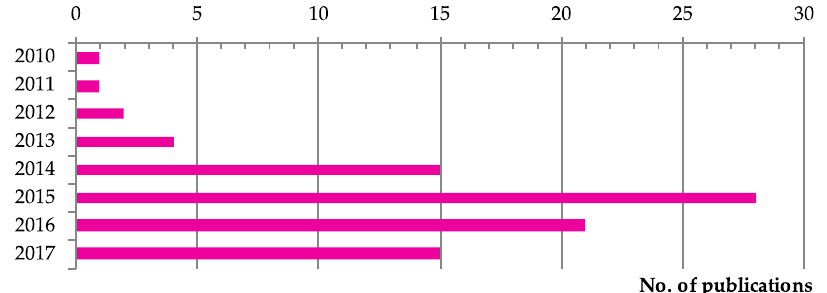
Figure 6 . Cost-optimal studies by publication year. Figure 6. Cost-optimal studies by publication